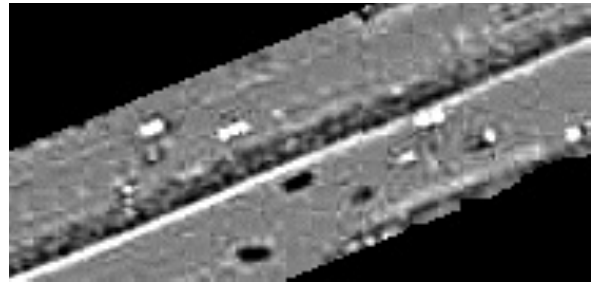
Figure 3: Enhanced texture around vehicles